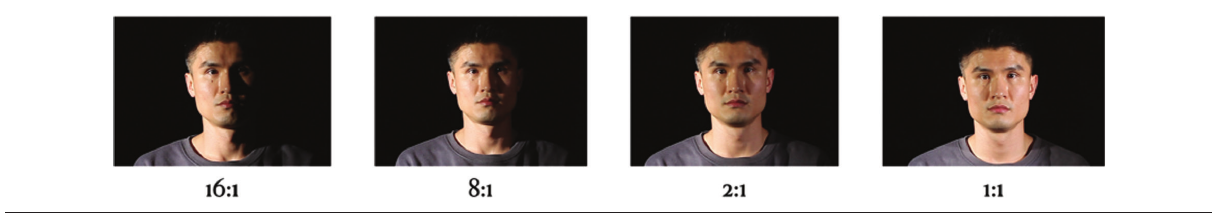
Figure 2. Different lighting ratios applied on the same face for specific types of image representation (Source: Author,